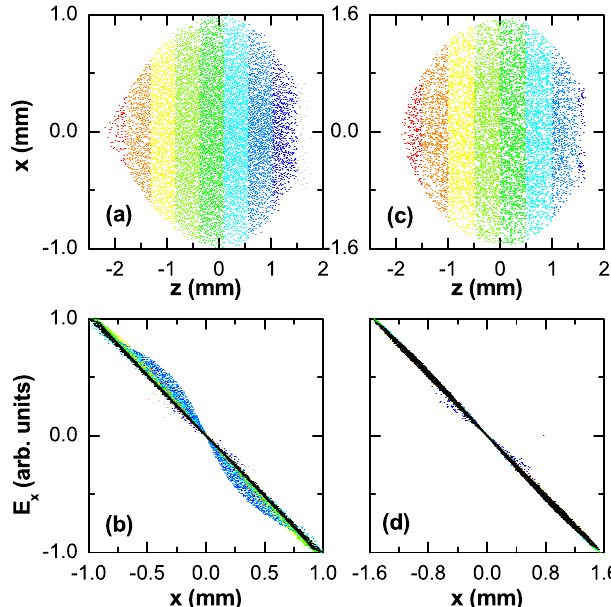
FIG. 4. (Color) Particle distributions projected onto the z - x plane for the shaped case and space-charge field distributions for the shaped (colored) and ideal ellipsoidal (black) laser beam case: (a, b) in free space; (c, d) 2.4 cm away from the cathode in the rf gun. The field plots are color coded by the z position of the particles for the shaped laser case as shown in (a) and (c). The distribution (a) represents the electron beam distribution directly carried over from the laser pulse if there is no distortion effect.